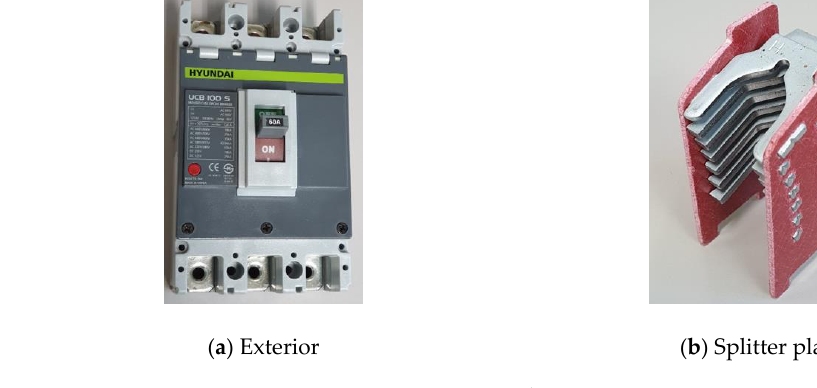
Figure 3. Research target MCCB.